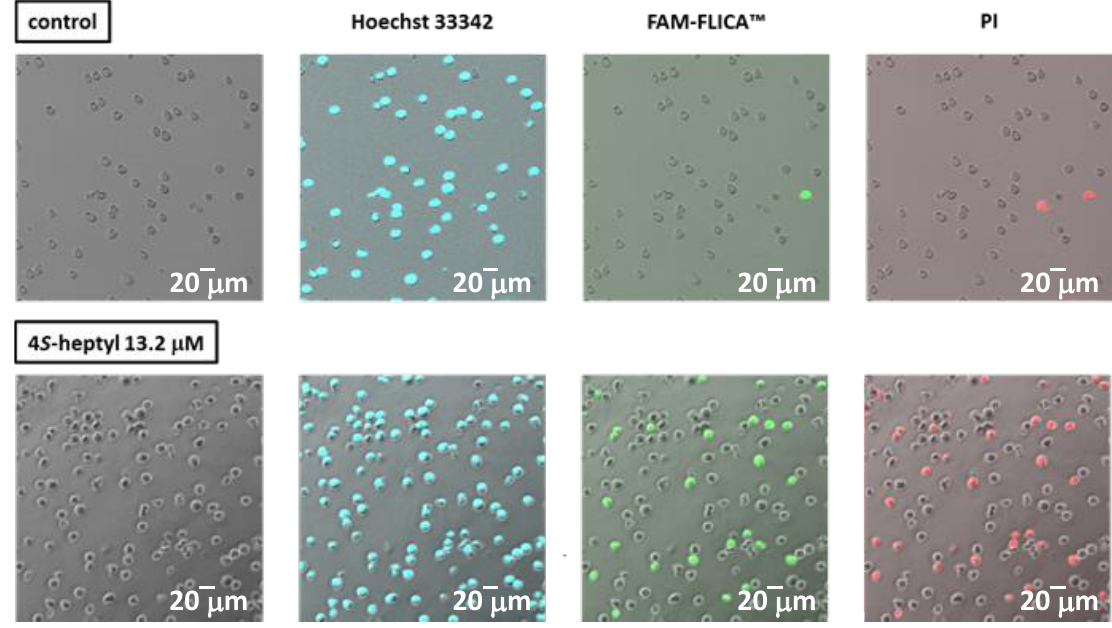
Figure 3. Fluorescence staining of HL60 cells treated with 4 S - n -heptyl derivative 9 .